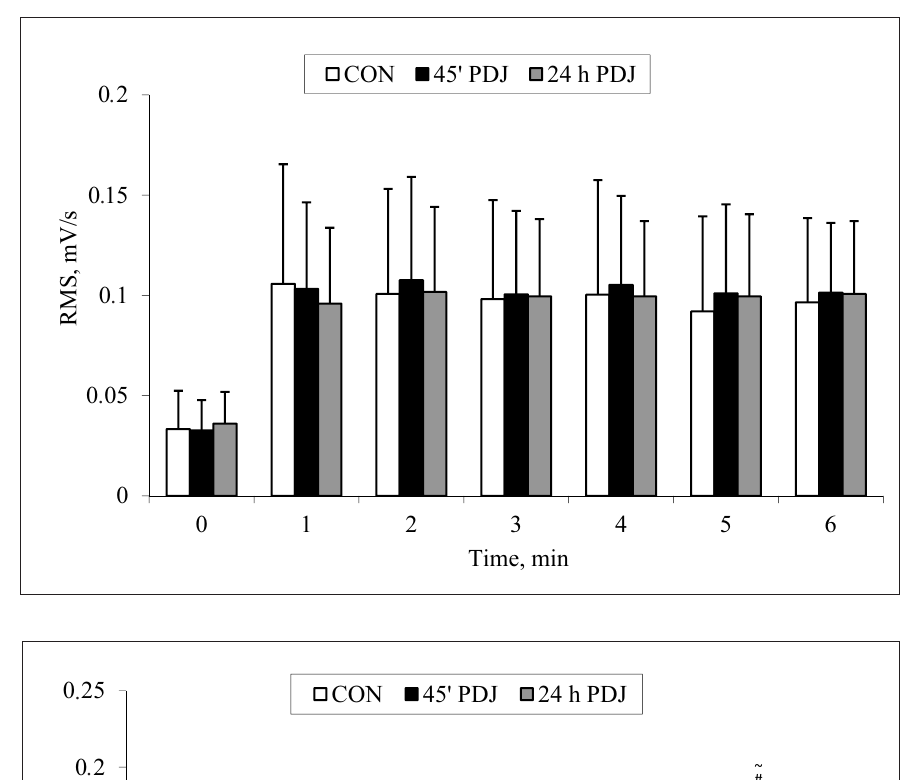
Figure 2. Group mean response of m. vastus medialis in RMS of sEMG during moderate cycling exercise control condition (CON); 45 minutes after prior